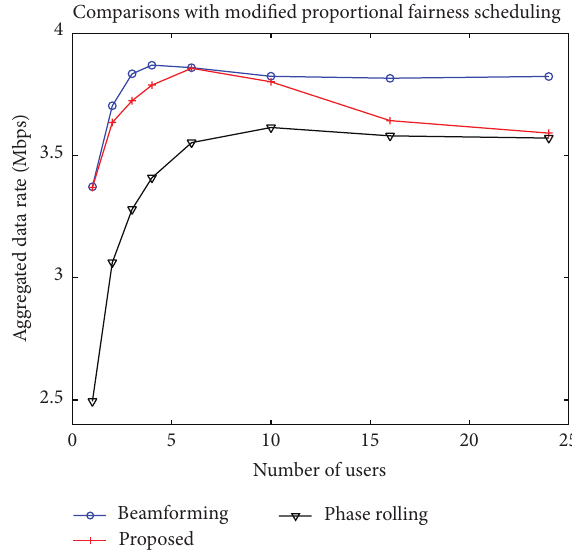
Figure 5: Resulting channel energy.